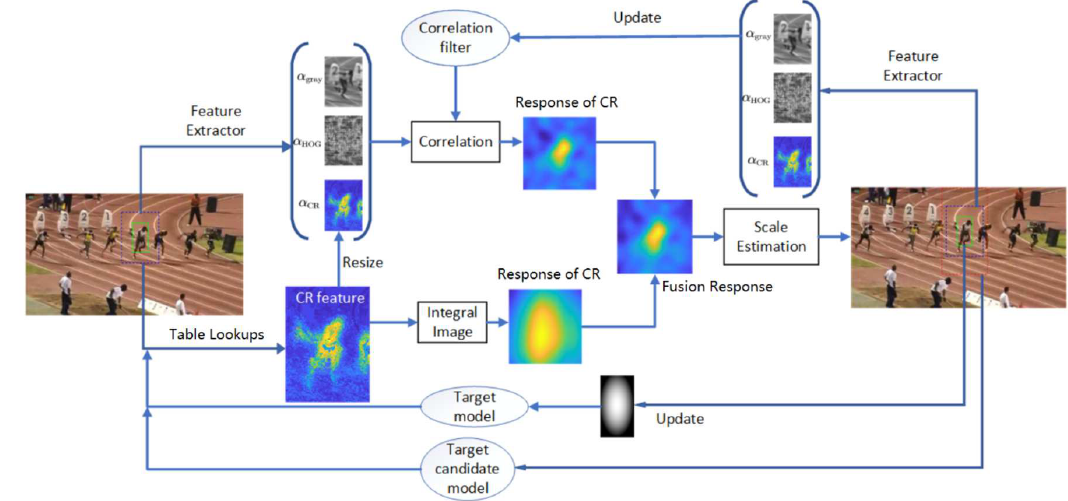
Figure 1. The overall sketch of CRCF tracker.